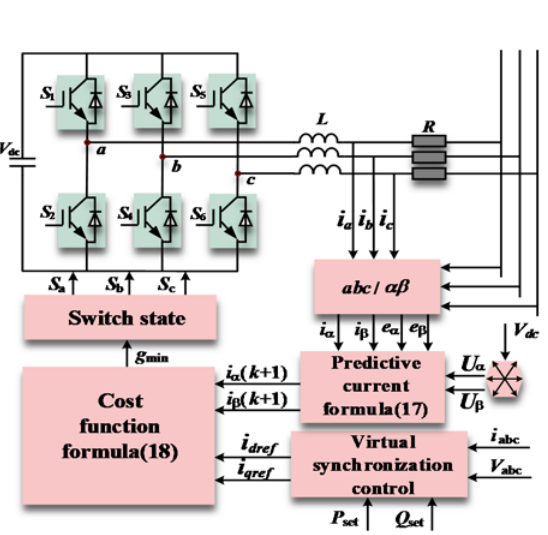
Figure 5. Model predictive virtual synchronous control diagram.